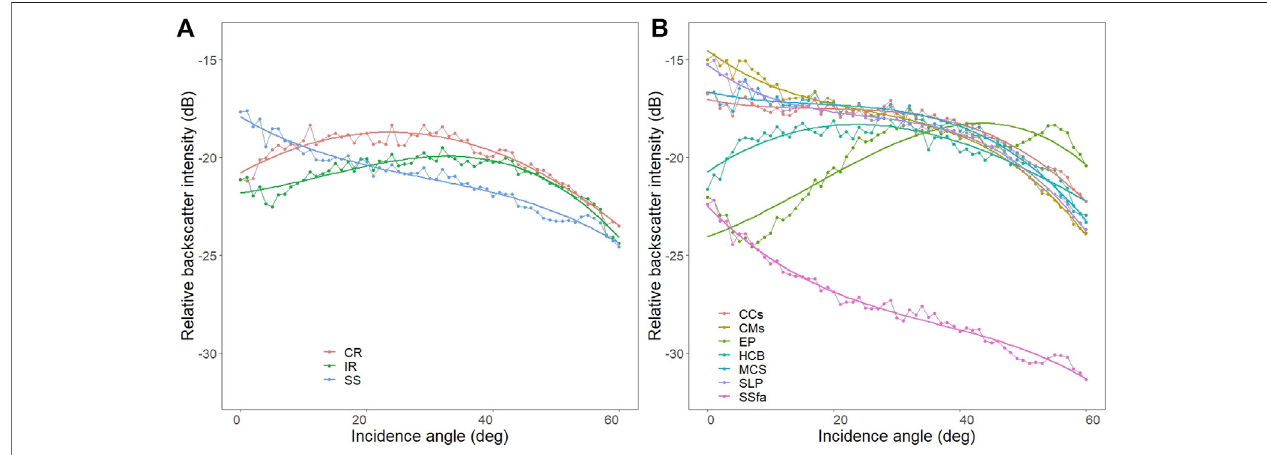
FIGURE 6 | Mean angular response curves from groundtruth observations for BC2 classes (A) and BC4 classes (B) . See Table 2 for full class names.